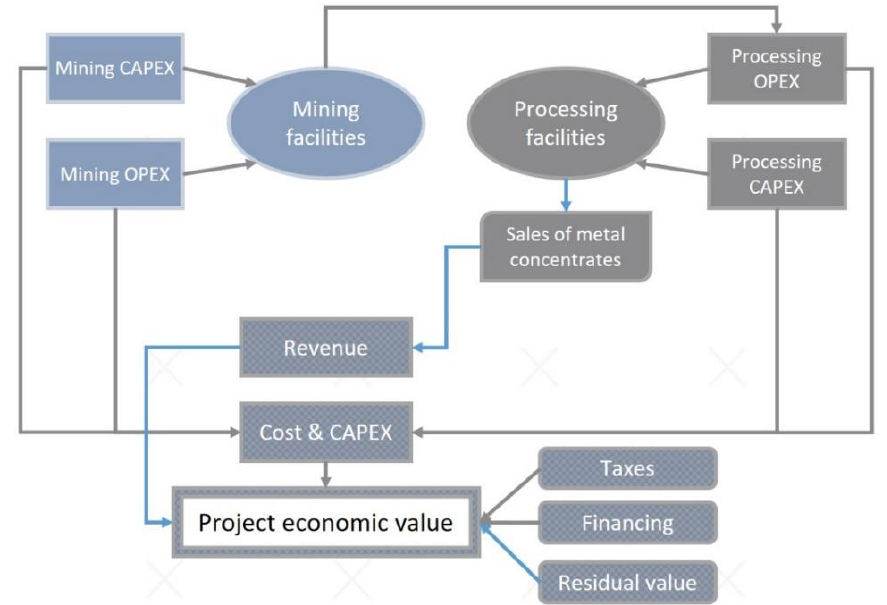
Figure 1. The structure of the deep-sea mining project economic assessment.